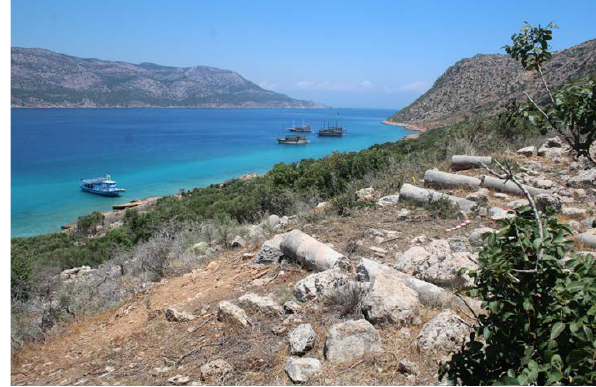
Figure 5. Remnants of a Greek-Roman